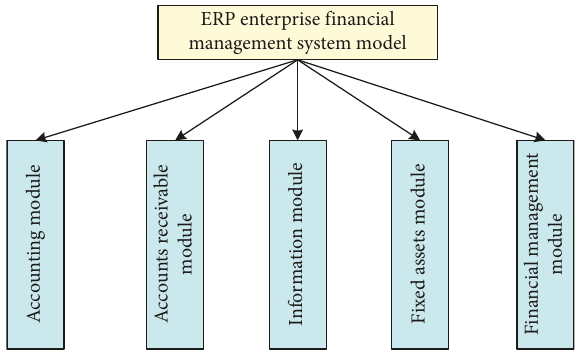
Figure 2: ERP enterprise financial management system